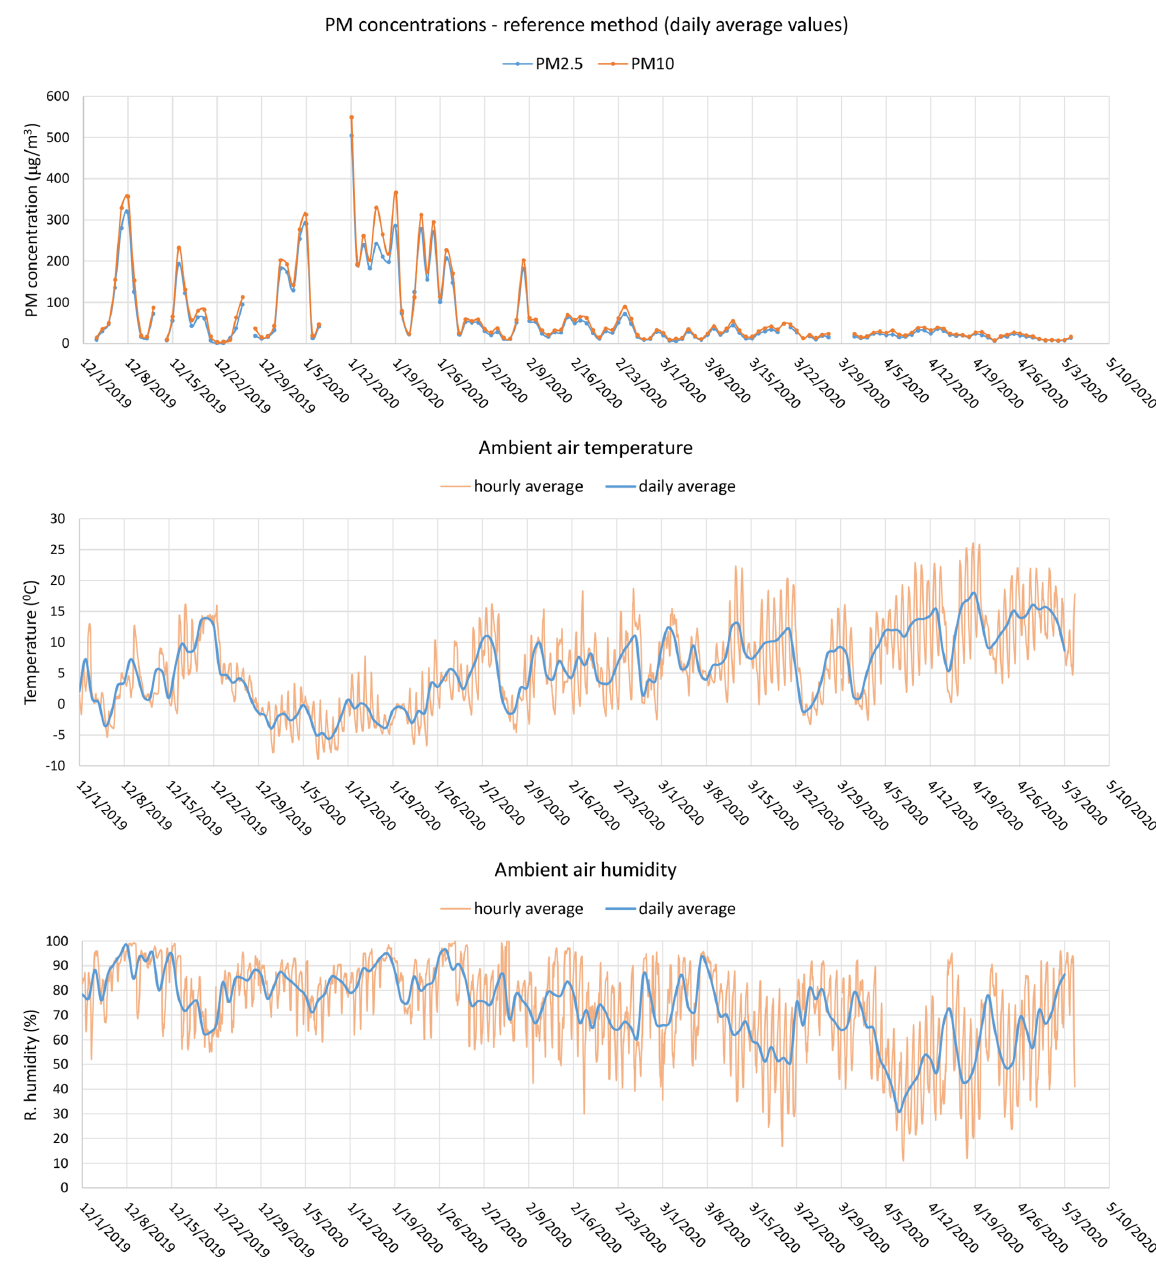
Figure 4. Reference PM concentrations with ambient air temperature and